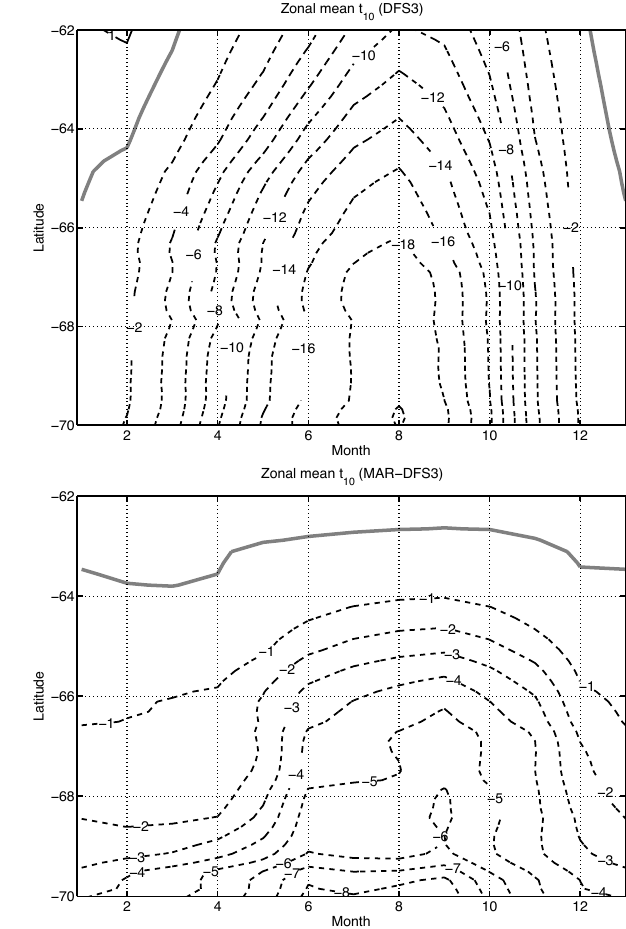
Fig. 3. Zonal average (0 ◦ E–150 ◦ E) of the mean surface air tem- perature (t 10 ) over 1980–1989 in DFS3 (top) and of the difference of t 10 between MAR and DFS3 (bottom). Top: the thick grey lines correspond to the 0 ◦ C isotherm. Bottom: the thick grey lines corre- spond to the 0 line, and negative values (dashed lines) mean a colder atmosphere in